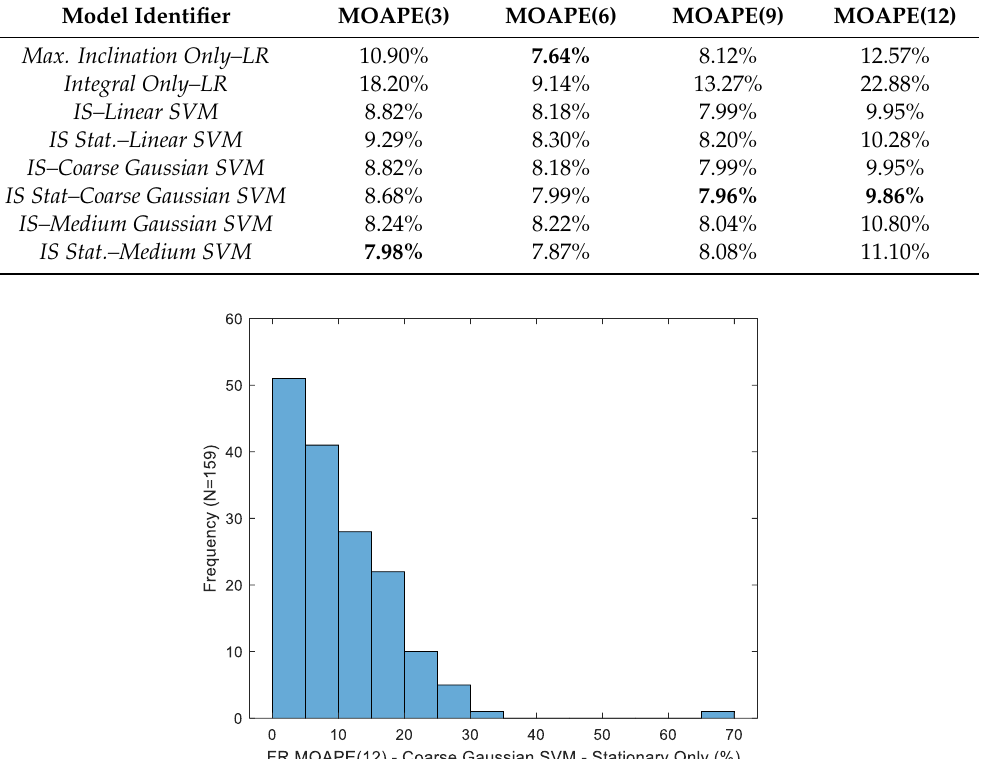
Table 5. Variation in the mean overall absolute percentage error for multiple prompt periods – fill ratio estimation (bold values emphasize the best performing model for each period).